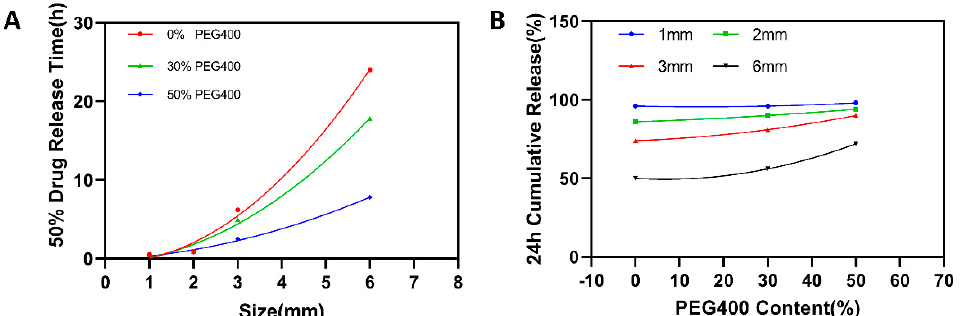
Figure 9. ( A ) Relationship between PEG400 content ratio ( w / w ), pellet size (mm), and 50% drug release time. ( B ) Relationship between PEG400 content ratio ( w / w ), pellet size (mm), and 24 h cumulative release